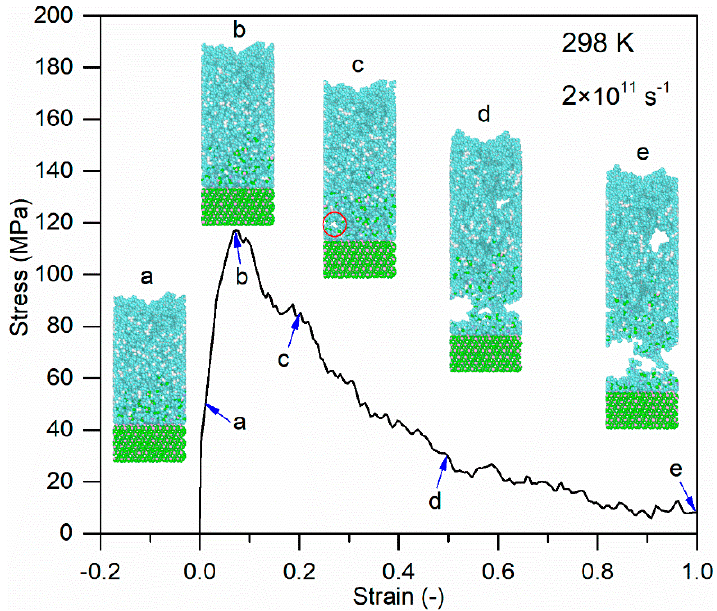
Figure 12. The configuration evolution of the glass fiber/PP material system during tensile loading at the loading temperature of 298 K and the strain rate of 2 × 10 11 s − 1 .